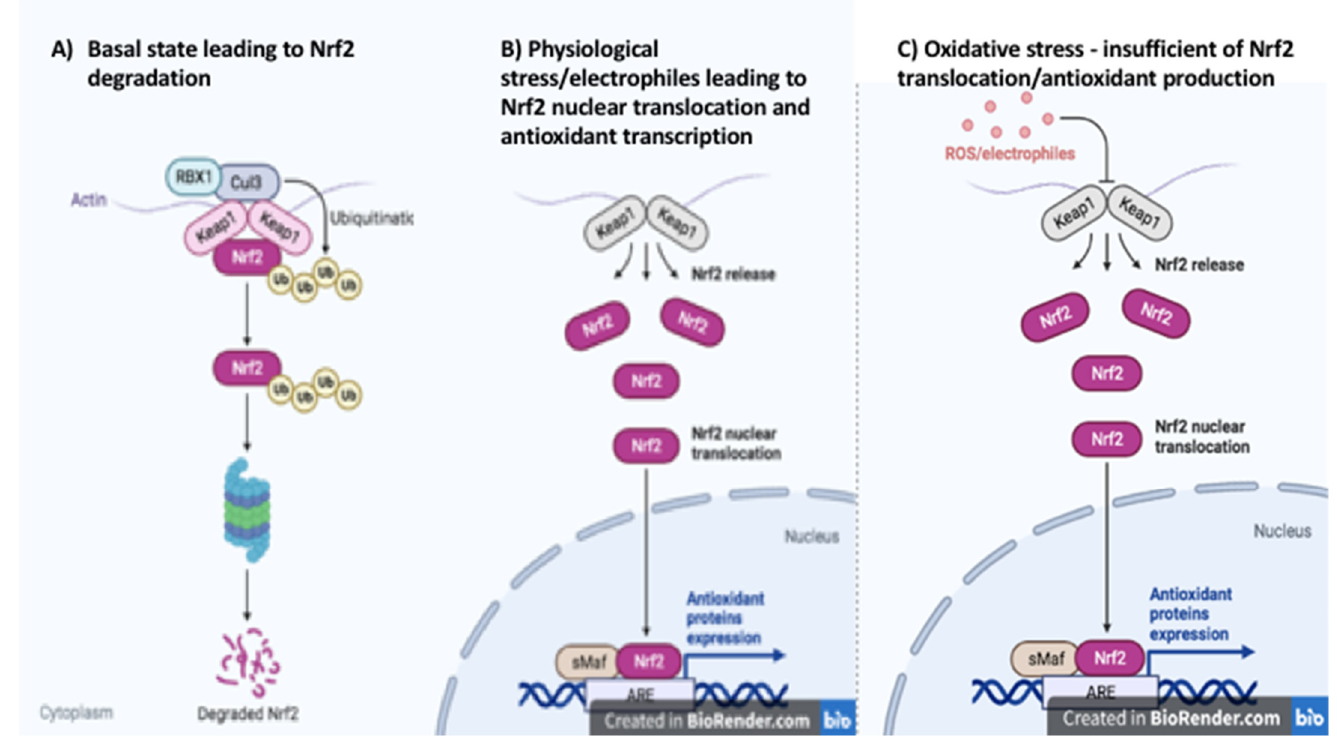
Figure 1. Keap1–Nrf2 Pathway. ( A ) basal state leading to Nrf2 degradation, ( B ) physiological stress/electrophiles leading to Nrf2 nuclear translocation and antioxidant transcription, ( C ) oxidative stress—insufficient of Nrf2 translocation/antioxidant production (created in BioRender.com, accessed on 20 July